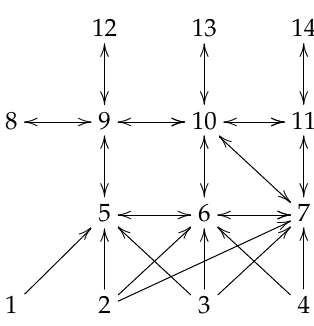
Figure 1. The network topology associated with vehicles 1 to 14. Here i denotes vehicle i , i = 1, · · · ,14.